Question: Briefly state, in one sentence, what is plotted here.
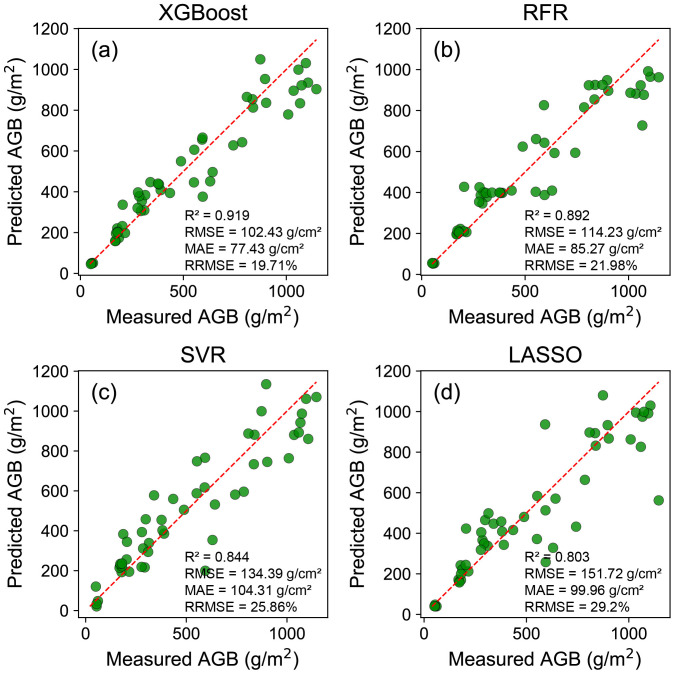
Answer: Comparison of measured and predicted wheat biomass using different machine learning models. (a) XGBoost, (b) RFR, (c) SVR, (d) LASSO.